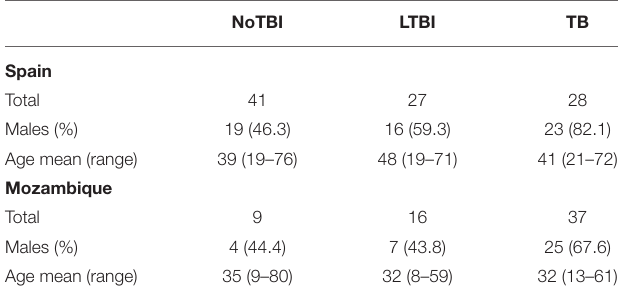
TABLE 2 | Demographical composition of the Spanish and Mozambican